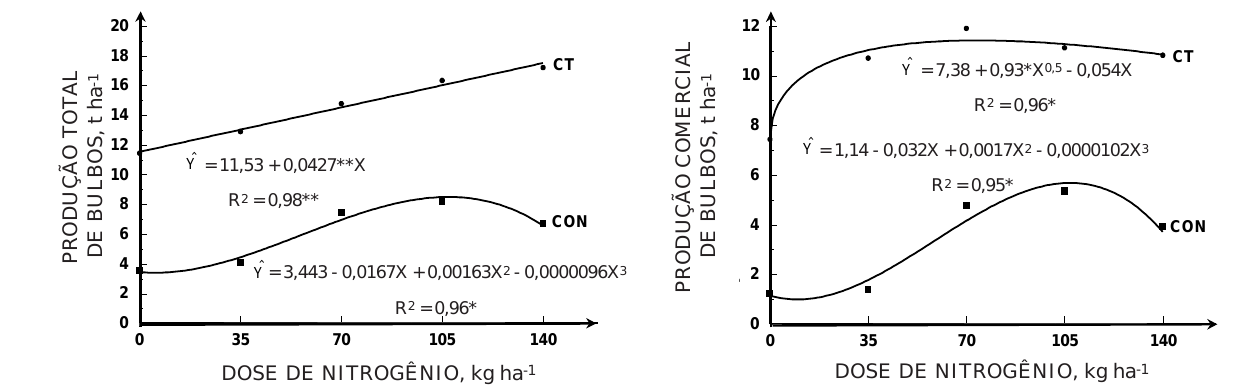
Figura 3 . Produção total de bulbos por plantas de alho provenientes de cultura de tecidos (CT) e multiplicação convencional (CON), consideran- do as doses de nitrogênio. *, ** significativos a 5 e 1%, respectivamente, pelo teste t.